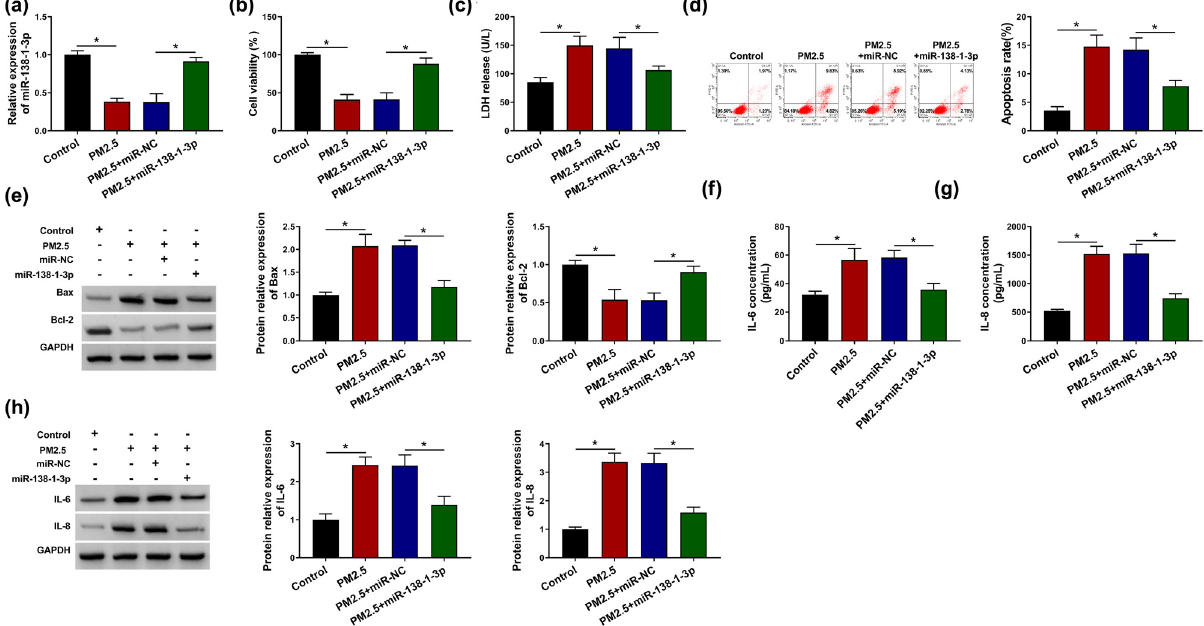
Figure 4: miR - 138 - 1 - 3p alleviated PM2.5 - induced cell death and in fl ammatory response in BEAS - 2B cells. BEAS - 2B cells were transfected with miR - NC or miR - 138 - 1 - 3p, followed by treatment with 75 μ g/mL PM2.5 for 48 h. ( a ) RT - qPCR analysis of miR - 138 - 1 - 3p expression in BEAS - 2B cells. ( b ) BEAS - 2B cell viability analysis using CCK - 8 assay. ( c ) LDH release detection in BEAS - 2B cells using LDH assay. ( d ) Flow cytometry of BEAS - 2B cell apoptosis. ( e ) Western blot analysis of Bax and Bcl - 2 expression in BEAS - 2B cells. ( f – h ) Levels detection of IL - 6 and IL - 8 expression in BEAS - 2B cells using ELISA and western blot analyses. N = 3, * P <